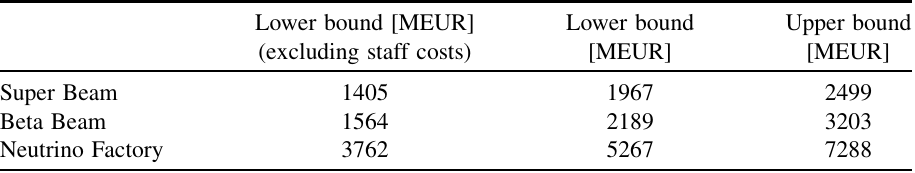
TABLE III. Total cost for the accelerator facilities and the relevant detectors. Note that the lower bound without staff costs just uses a 40% scaling factor.